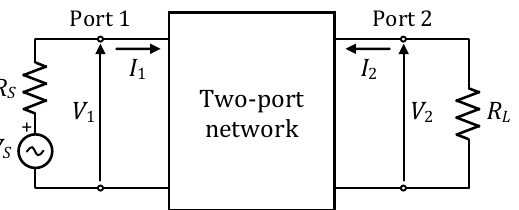
Figure 3. The magnetically coupled resonant wireless power transmission system represented as a two-port passive linear network model with the S-parameters.